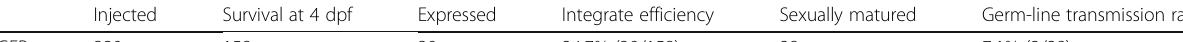
Table 2 Results of microinjection targeting the gap43 locus with GFP or RFP